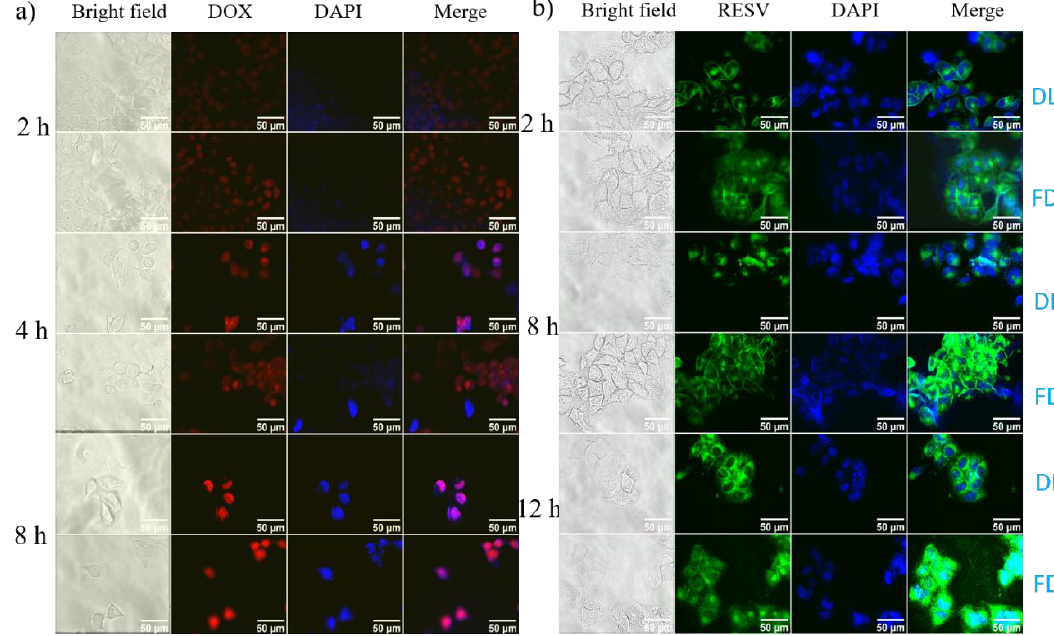
Figure 9. Fluorescence microscope images of HeLa cells incubated with ( a ) G4.5-DOX and ( b ) Na- DOC-hyd-RESV (in all treatment 2.5 µg mL −1 and 7.5 µg mL −1 equivalent concentration of DOX and RESV, respectively, were used), [DL = drug loaded materials treated cells (Na-DOC-hyd-RESV or G4.5-DOX) and FD = free drugs (RESV or